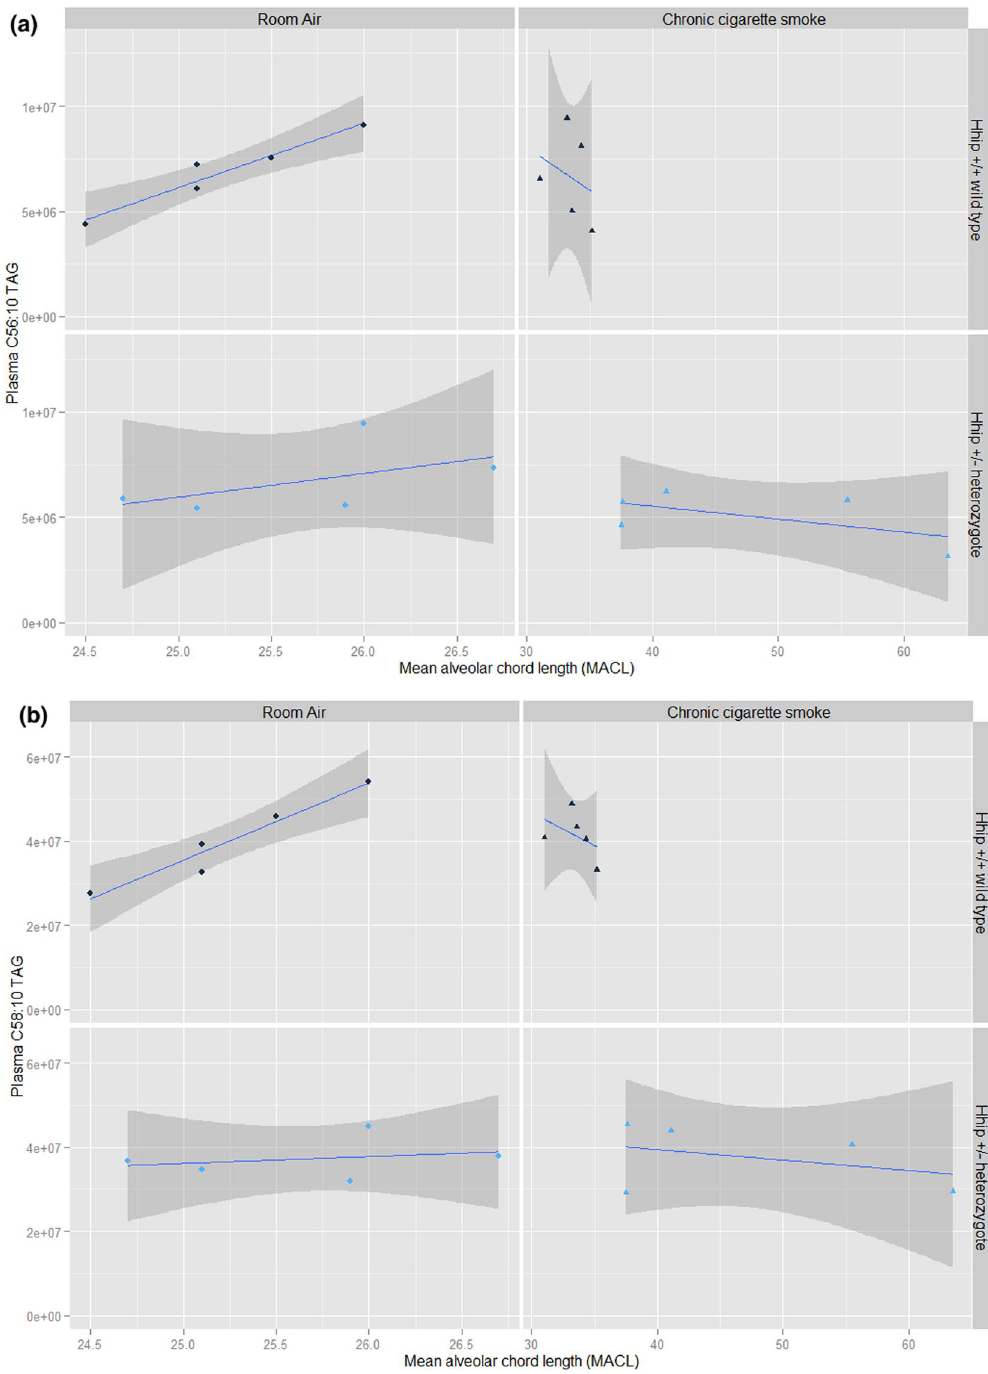
Figure 2. Association between plasma C56:10 (panel A) and C58:10 (panel B) triacylglycerol (TAG) and lung mean alveolar chord length (MACL) by experimental condition. A strong correlation between C56:10 TAG (Panel A, Pearson’s rho = 0.97, p-value = 7.22 × 10 –3 ) and C58:10 TAG (Panel B, Pearson’s rho = 0.97, p-value = 7.14 × 10 –3 ) and MACL is observed Hhip + / + wild type exposed to room air which is not observed in Hhip + / + wild type exposed to chronic cigarette smoke or in Hhip + / − heterozygotes exposed to either experimental condition. The best fit line is plotted in blue while the 95% confidence interval is plotted in dark